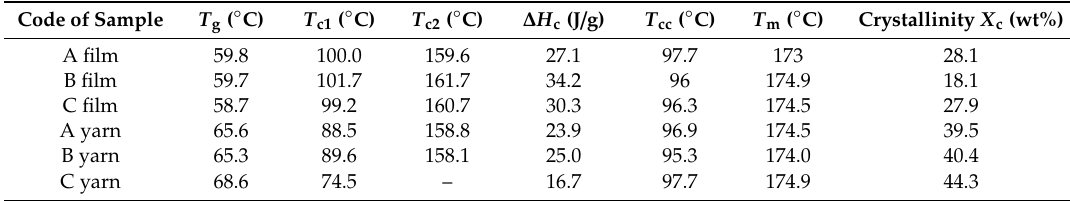
Table 1. Di ff erential scanning calorimetry (DSC) analysis of pure PLA and modified PLA with myrrh extracts films and multifilament yarns.